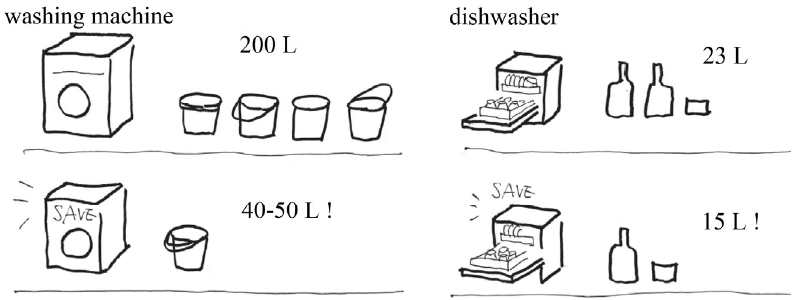
Figure 3. Water consumption of conventional household appliances ( top ), compared to that of water saving household appliances ( bottom